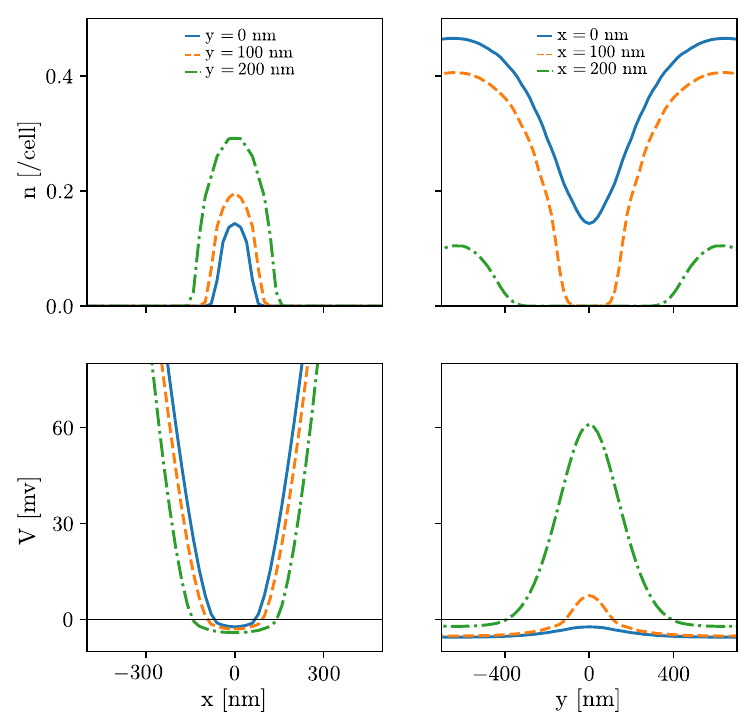
Figure 14: Cut of Fig. 13 at constant x (left) and y (right) for the density (upper panels) and potential (lower panels). The cut correspond to x , y = 0 (blue), 100 (dashed orange) and 200 nm (dot dashed green). The QPC gate voltage is set at = − 0.37 V g